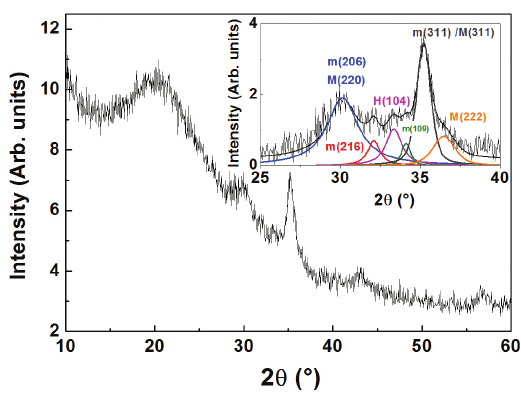
Figure 1. Diffractogram of the synthesized sample, the inset shows the possible existence of iron oxides magnetite (M), maghemite (m) and / or hematite